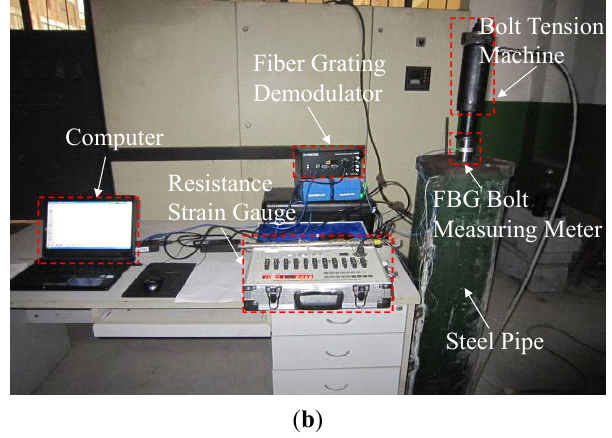
Figure 6. Bolt pull-out test setup. ( a ) Schematic diagram of the test setup; ( b ) Physical drawing of the test setup.